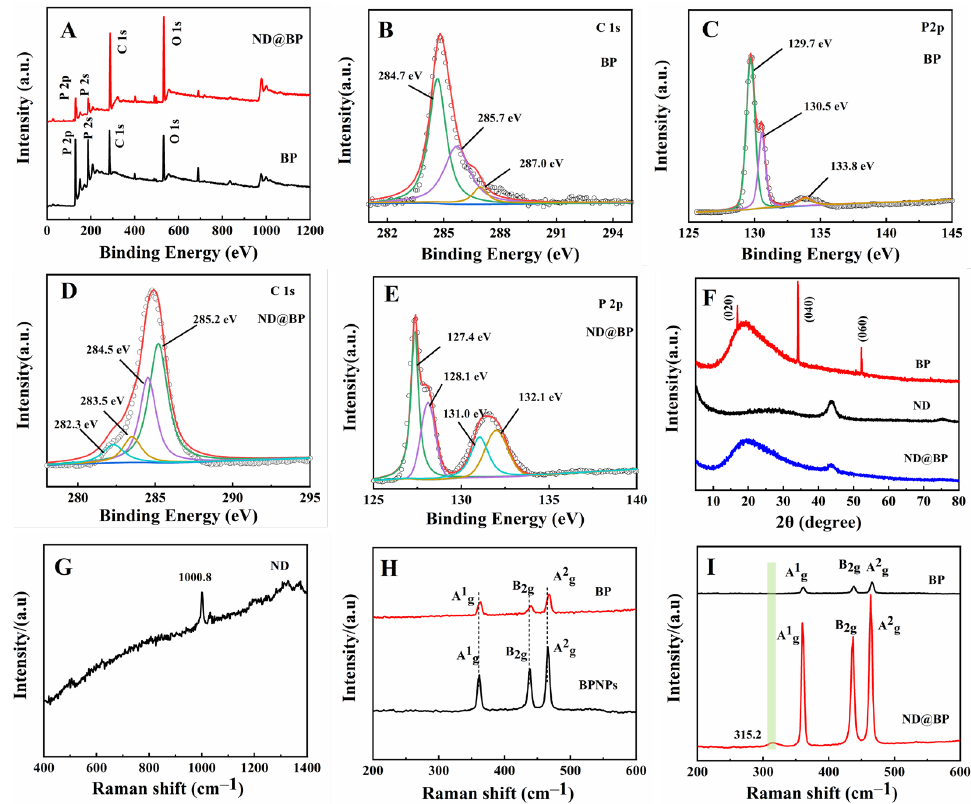
Figure 2. XPS survey spectrum of BP and ND@BP ( A ); high-resolution XPS spectra of the C 1s ( B ) and P2p ( C ) signal for BP; high-resolution XPS spectra of the C 1s ( D ) and P 2p ( E ) signal for ND@BP; XRD patterns of ND, BP, and ND@BP ( F ); Raman spectra of ( G ) ND, ( H ) BPNPs and BP, and ( I ) BP and ND@BP.